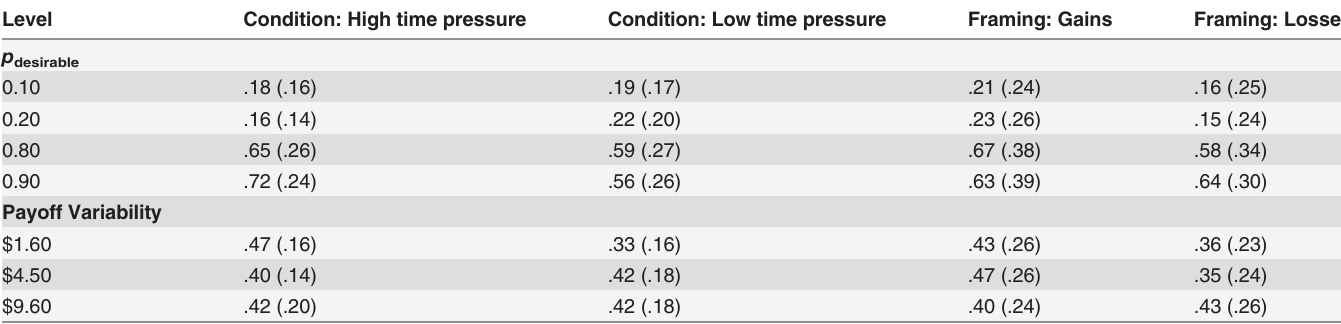
Table 5. Experiment 2 — Proportion of risky choices taken for differing levels of p desirable and payoff